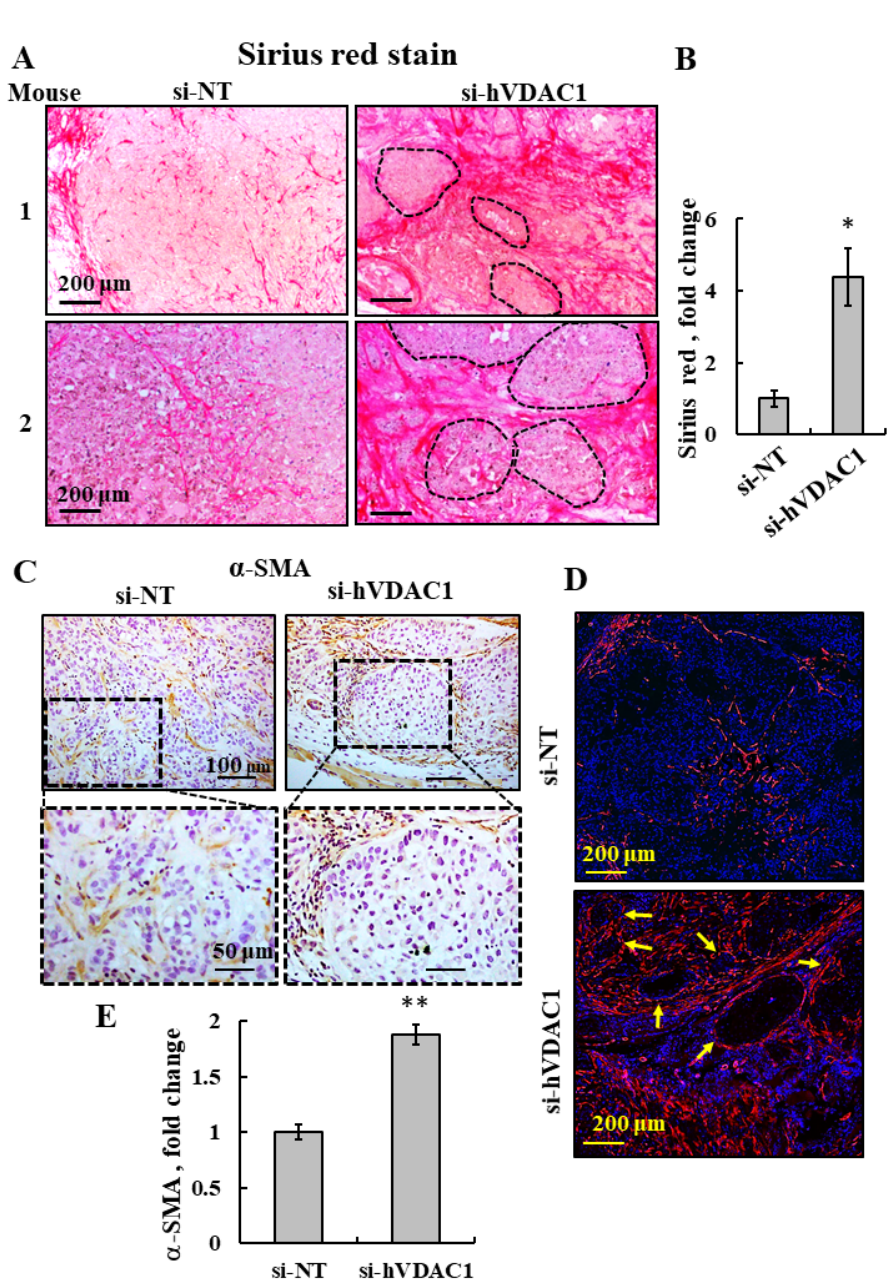
Figure 6. si-hVDAC1-2A-TTs show altered ECM organization and encapsulate cancer cells in the tumor. ( A ) Representative sections from two mice of si-NT-TT and si-hVDAC1-2A-TT sections derived from A549 xenografts stained with Sirius red. The dashed lines surround the encapsulated cancer cells within the residual tumor. ( B ) Quantitative analysis of Sirius red intensity. ( C , D ) Repre- sentative IHC ( C ) and IF ( D ) staining of si-NT-TT and si-hVDAC1-2A-TT sections with anti- α -SMA antibodies. Arrows point to the spherical organization of fibroblasts. ( E ) Quantitative analysis of α -SMA presented in ( D ). The results are the means ± SD, * p ≤ 0.05, ** p ≤